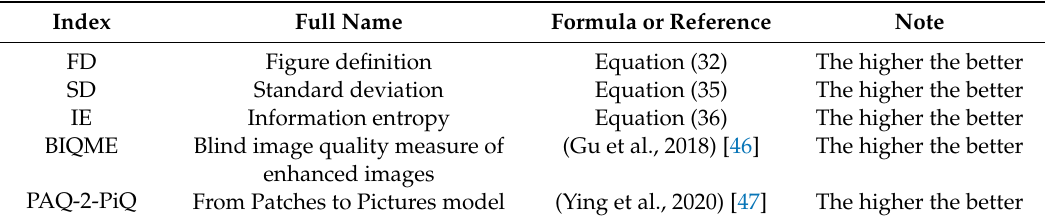
Table 4. The induction of the quantitative metrics used in real-data